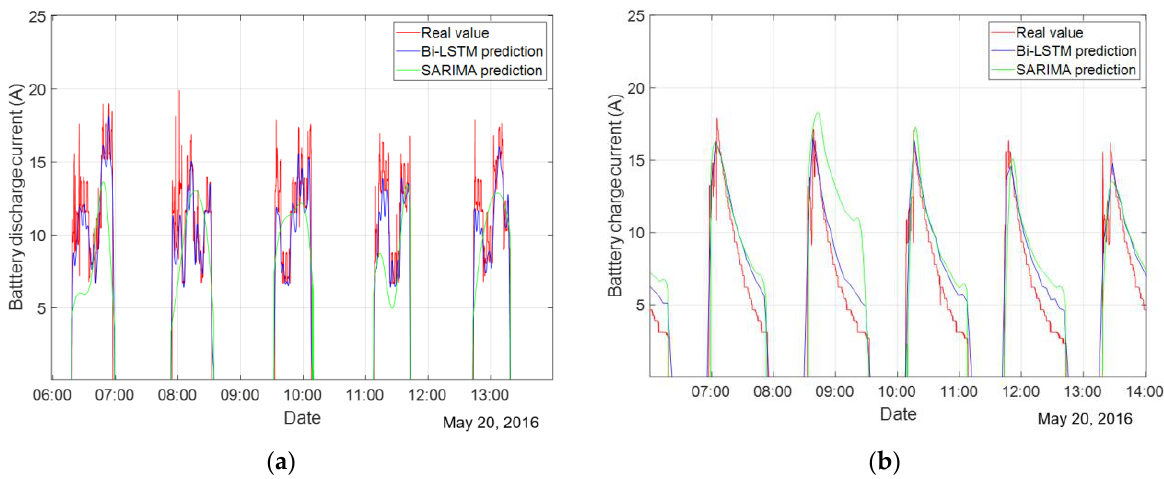
Figure 9. KOMPSAT-3A enlarged battery current prediction results: ( a ) discharge current; ( b ) charge current.